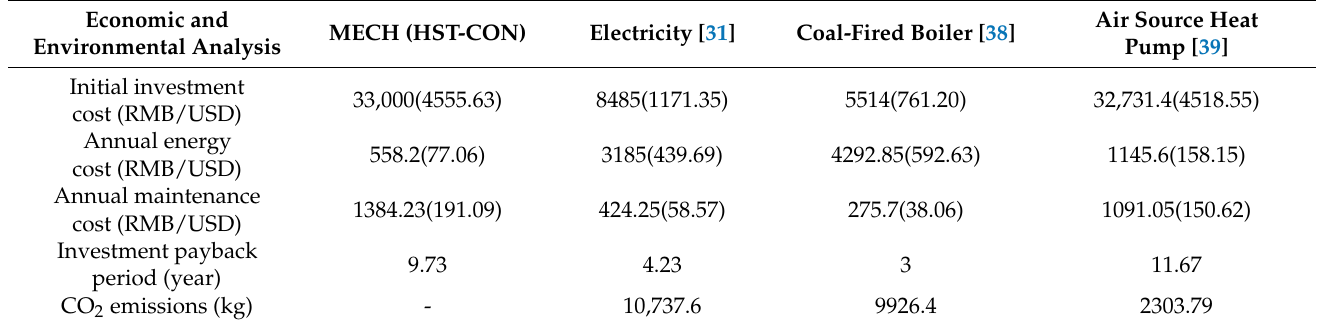
Table 3. Economic and environmental parameters of different heating